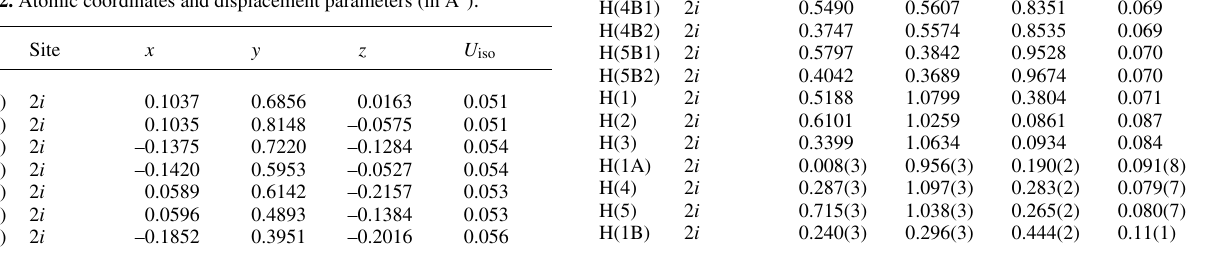
Table 2. Atomic coordinates and displacement parameters (in Å 2 ) .